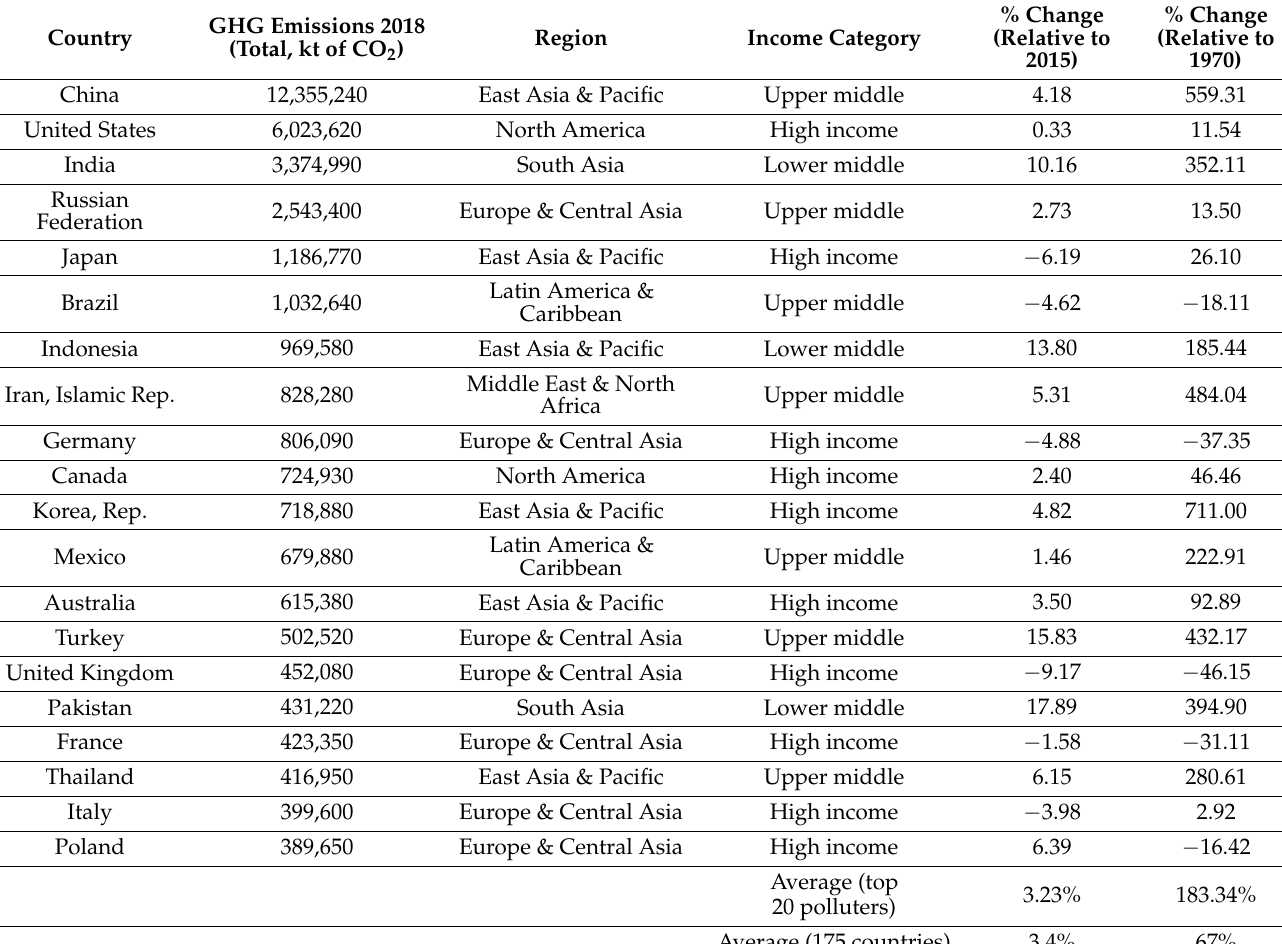
Table 1. Greenhouse Gas Emissions by Top Emitters, 2018 and emission trends